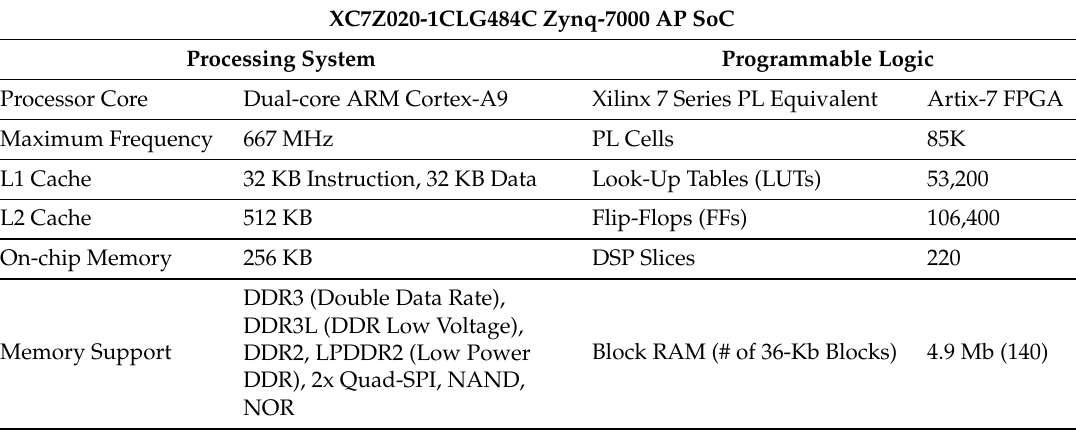
Table 1. Zedboard device feature summary